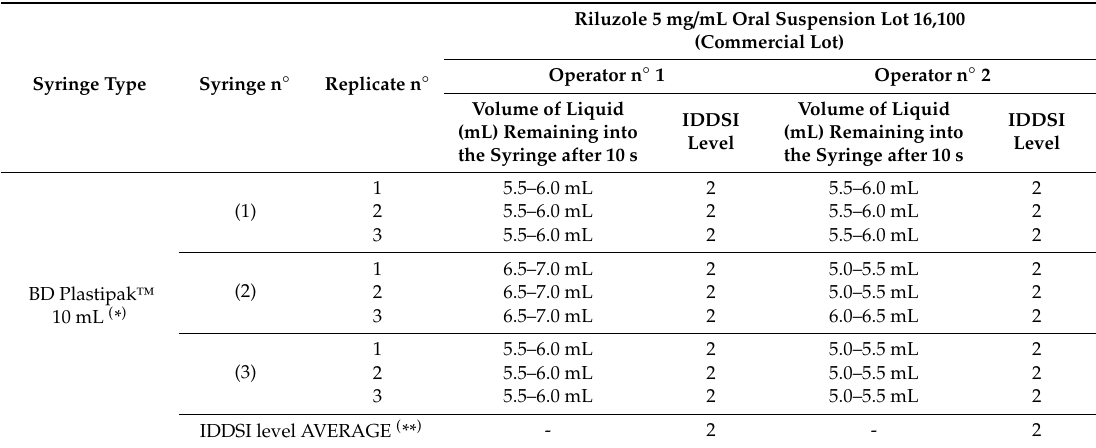
Table 4. Riluzole 5 mg / mL oral suspension (lot 16100): IDDSI Flow